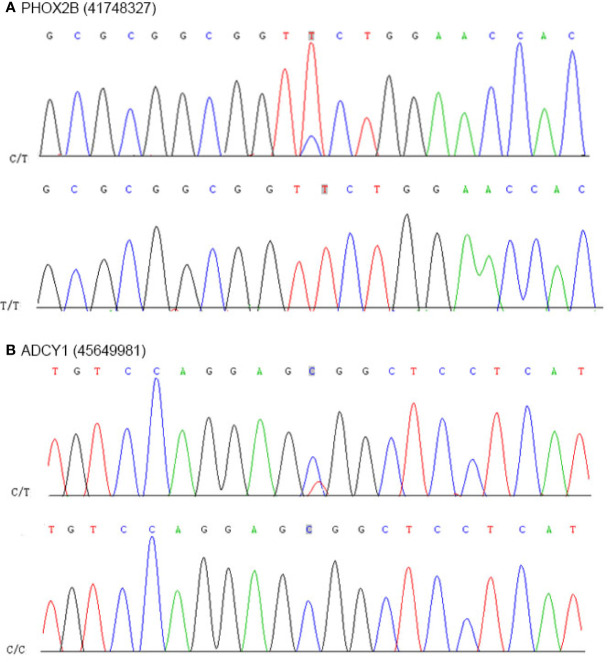
Results of nucleotide Sanger sequencing analysis. (A) Sanger sequencing electropherograms of the PHOX2B mutant at position chr19:41748327C>T. (B) Sanger sequencing electropherograms of the ADCY1 mutant at position chr19:45649981T>C.